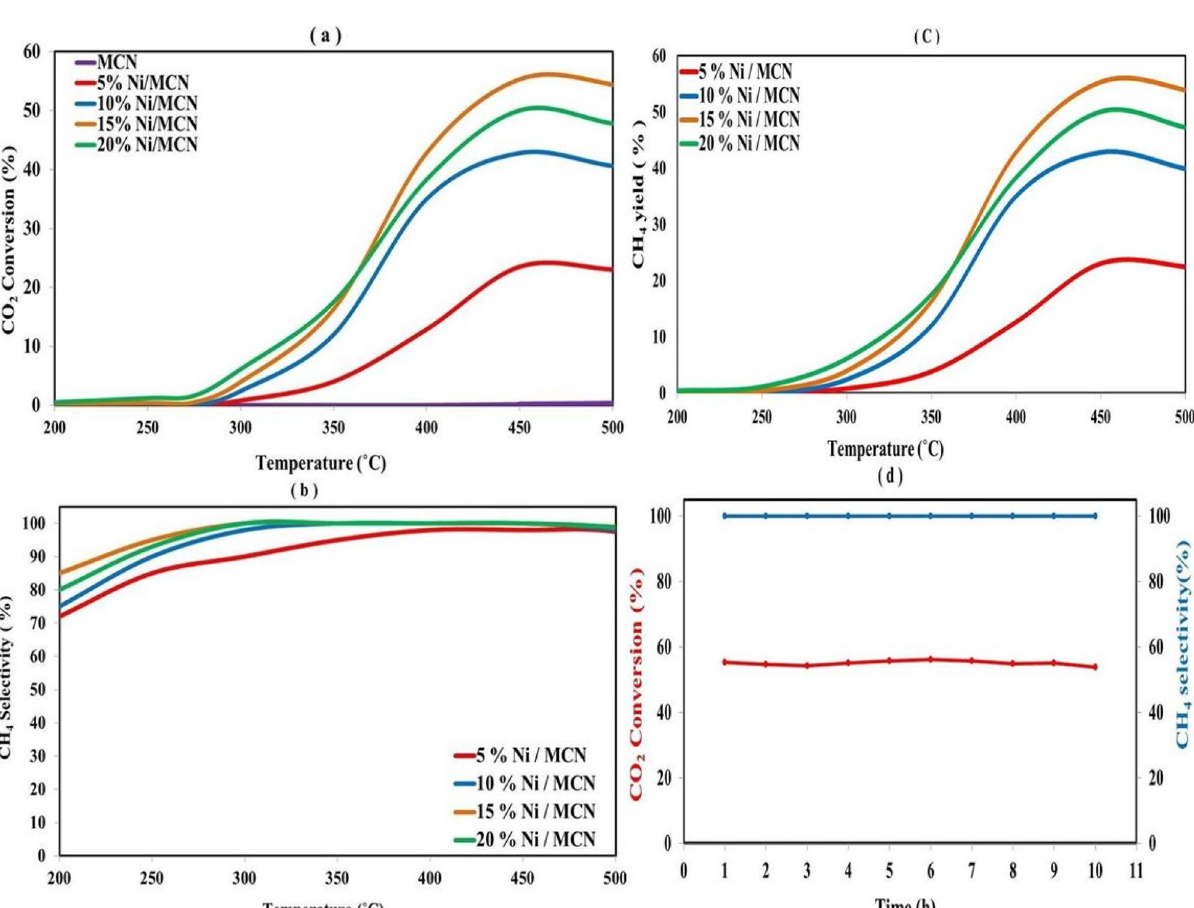
Figure 9. ( a ) CO 2 conversion capacity of the catalysts at different temperatures, ( b ) CH 4 selectivity of the catalysts at different temperatures, ( c ) CH 4 yield of the catalysts at different temperatures and d .short-term stability tests of 15Ni/ MCN at 450 °C and 1